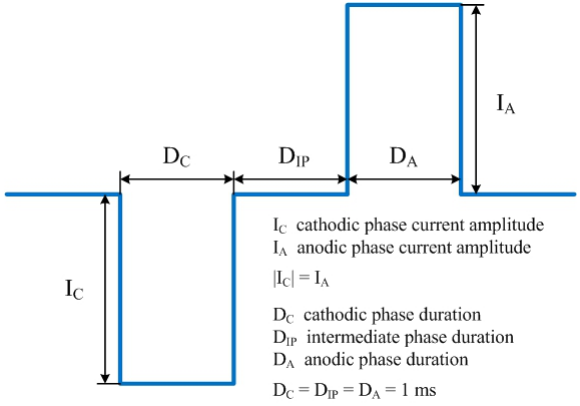
Figure 5. Cathodic-first biphasic symmetric square-shaped current pulse with 1 ms duration and 1 ms intermediate